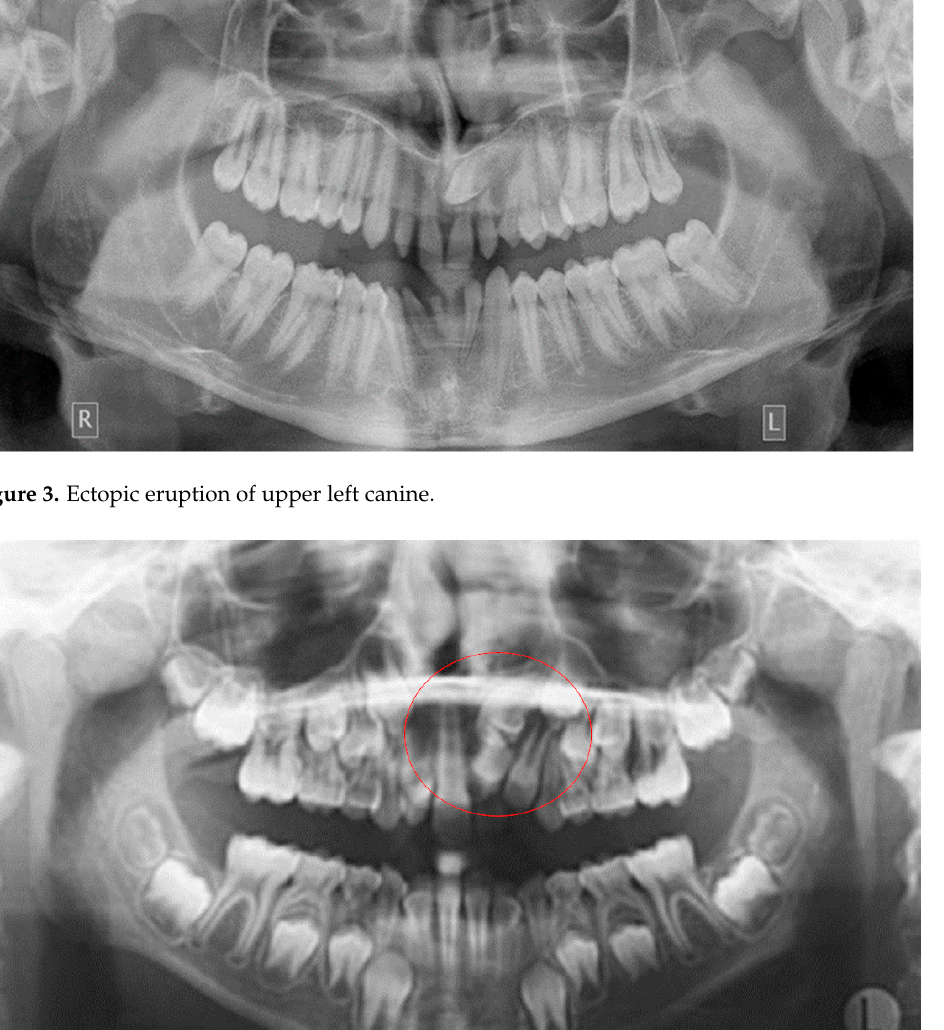
Figure 4. Odontoma in the anterior